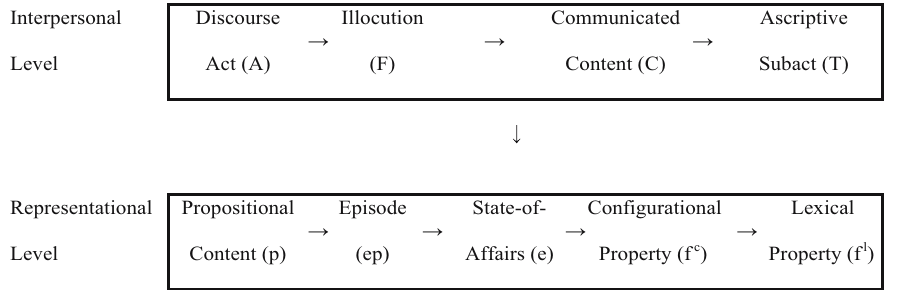
Figure 2: Layers and scope relations in